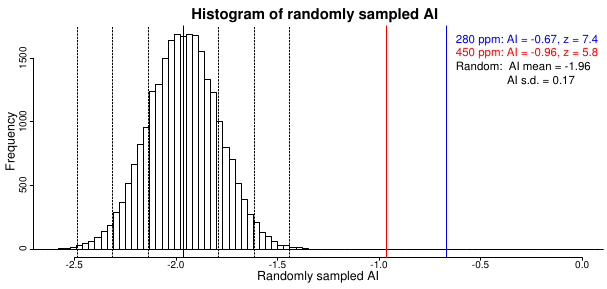
Figure 2. Agreement index with the null model distribution and the AI values shown for model runs with different CO 2 concentration.